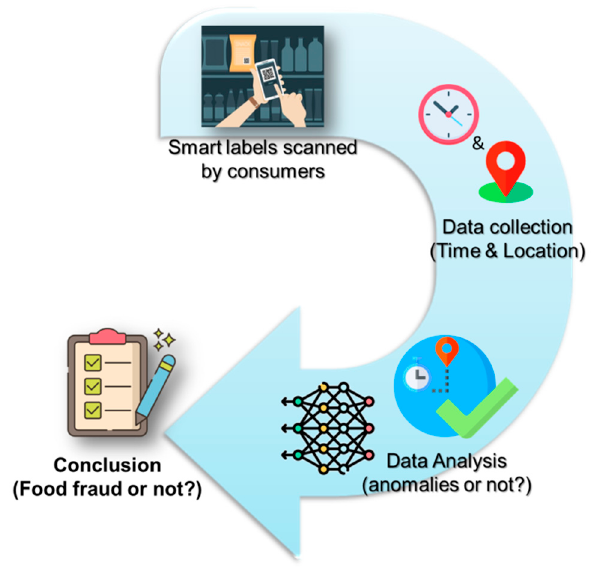
Figure 1. Outline of the use of spatial-temporal analysis of data collected from consumers who scan QR or other smart labels.